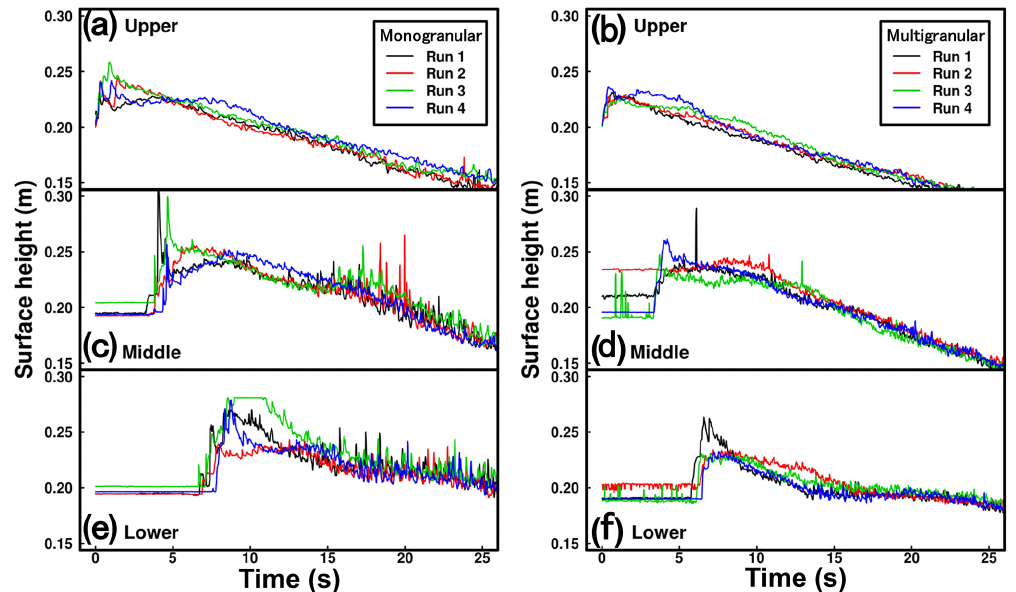
Figure 3. Changes in the debris-flow surface in the flume. The left and right panels show results of the monogranular and multigranular flows, respectively. The different colors of the lines correspond to respective experimental runs: (a, b) measurements at the upper measurement position, (c, d) measurements at the middle measurement position, and (e, f) measurements at the lower measurement position. The time ( x axis) was set to assume that the flow front arrived at the upper measurement position at time zero. Any change in the initial thickness of the bed surface (e.g., d ) due to local undulation was probably canceled out by the debris-flow descent.